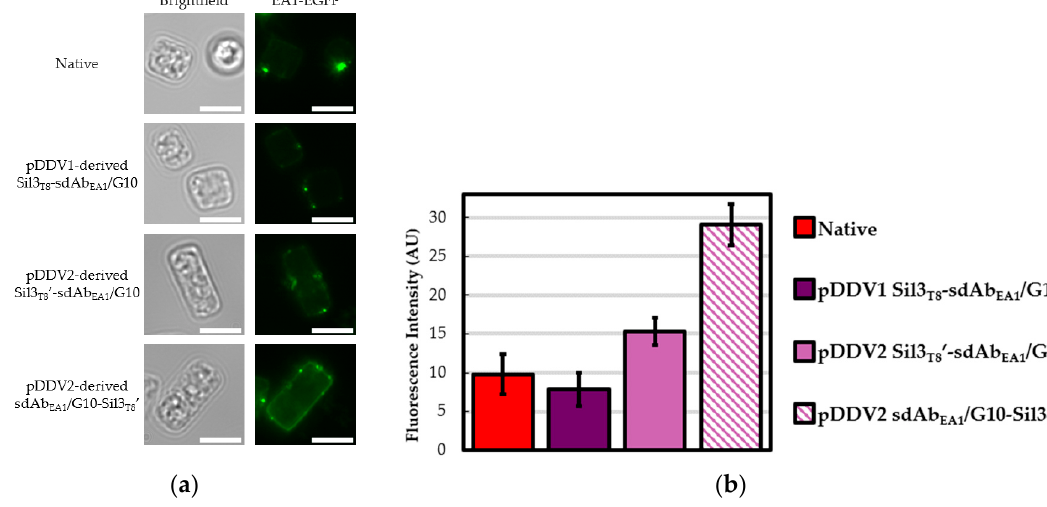
Figure 3. sdAb EA1 / G10 in vivo functionalized biosilica. Diatom biosilica was isolated from native T. pseudonana and cell lines transformed with constructs containing various Sil3 T8 -sdAb EA1 / G10 fusions. Presence of functional, in vivo assembled, biosilica-tethered sdAb EA1 / G10 was confirmed by ability to bind EA1-EGFP protein. As all six single domain antibody (sdAb) fusions were tested in a single experiment, the native diatom biosilica results are identical to those presented in the previous figure. ( a ) Epifluorescence images of representative frustules showing di ff erent EA1-EGFP binding potentials. Given that S-layer proteins like EA1 (and, by extension, the EA1-EGFP used here) are self-assembling [31], the punctate fluorescence observed in all four panels is expected and contributes to the fluorescent signal observed for the native frustules. All calibration bars are 5 µ m. ( b ) Average measured fluorescence intensities in arbitrary units (AU). Error bars are 95% confidence intervals ( ± t × 1 SEM). For native and pDDV1-derived Sil3 T8 -sdAb EA1 / G10 biosilica frustules, n = 25 (df = 24, t = 2.06); pDDV2-derived Sil3 T8 (cid:48) -sdAb EA1 / G10 and sdAb EA1 / G10-Sil3 T8 (cid:48) biosilica frustules, n = 100 (df = 99, t =